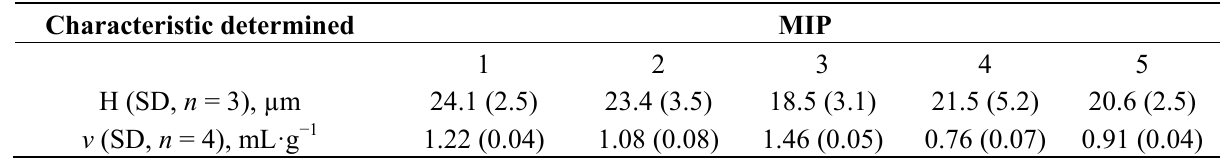
Table 1. Thickness (by SEM) and porosity (gravimetrical method) of films fabricated by the “sandwich” technique. (SD—standard